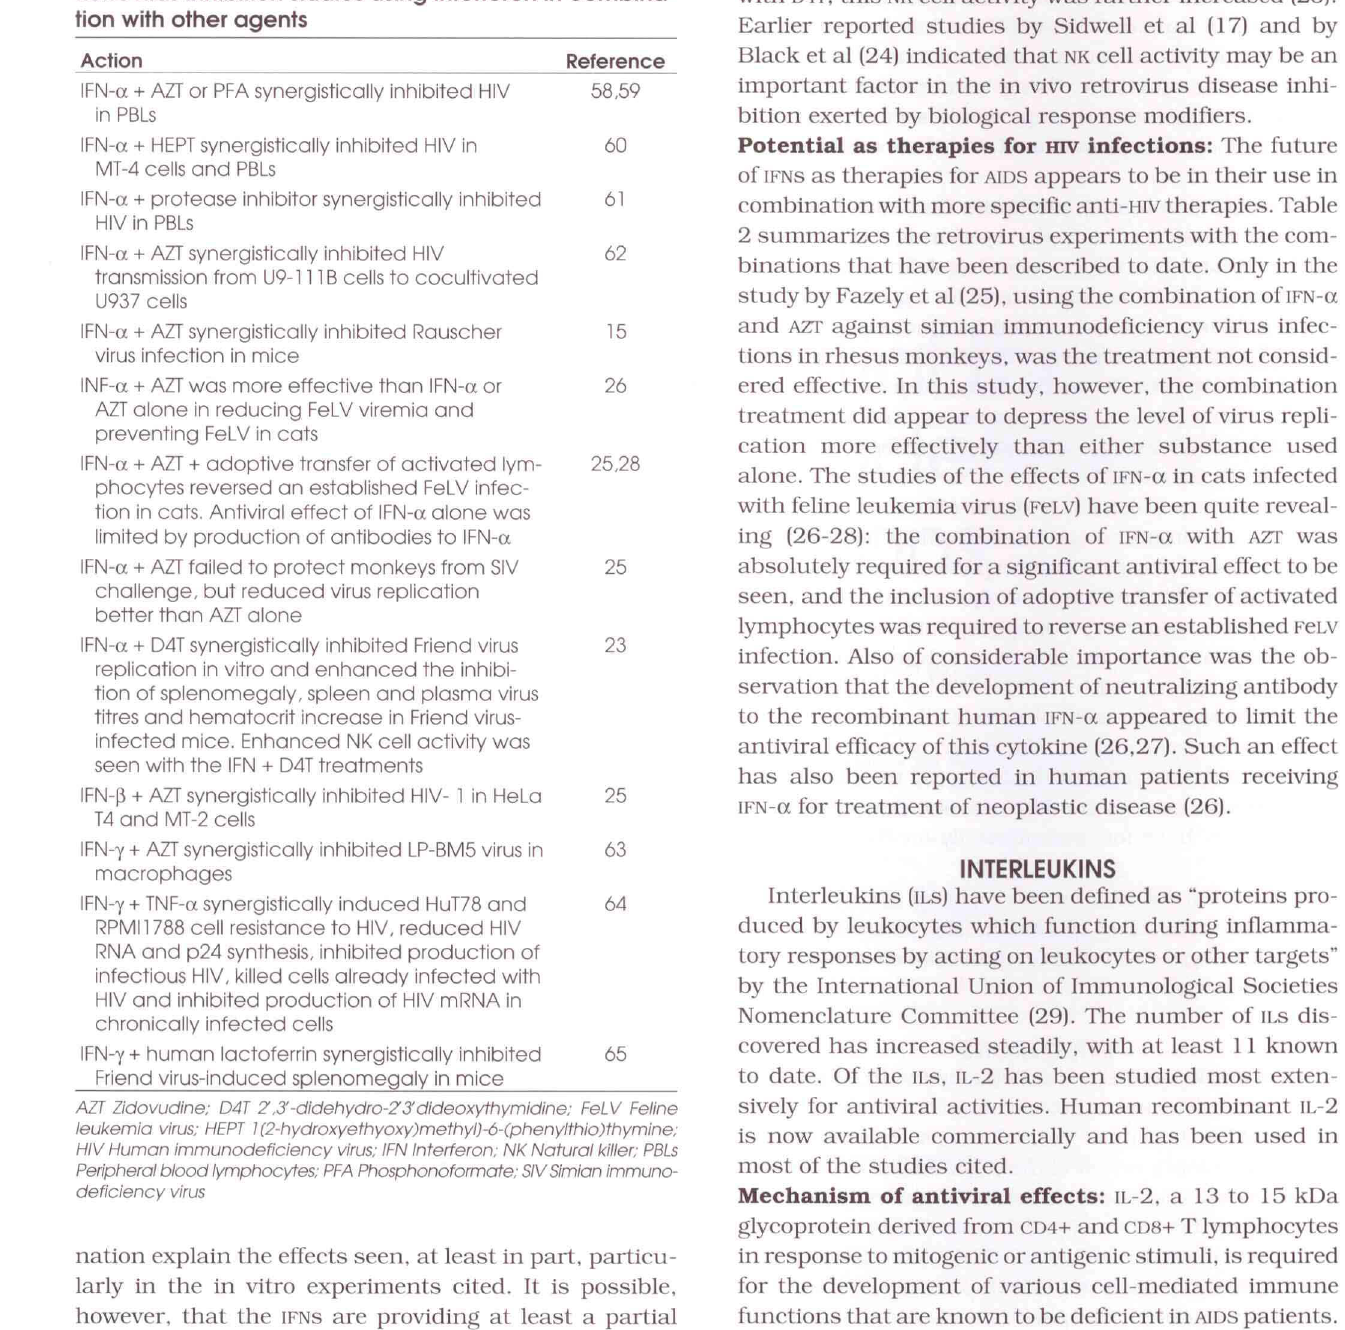
Retrovirus inhibition studies using interferon in combina tion with other